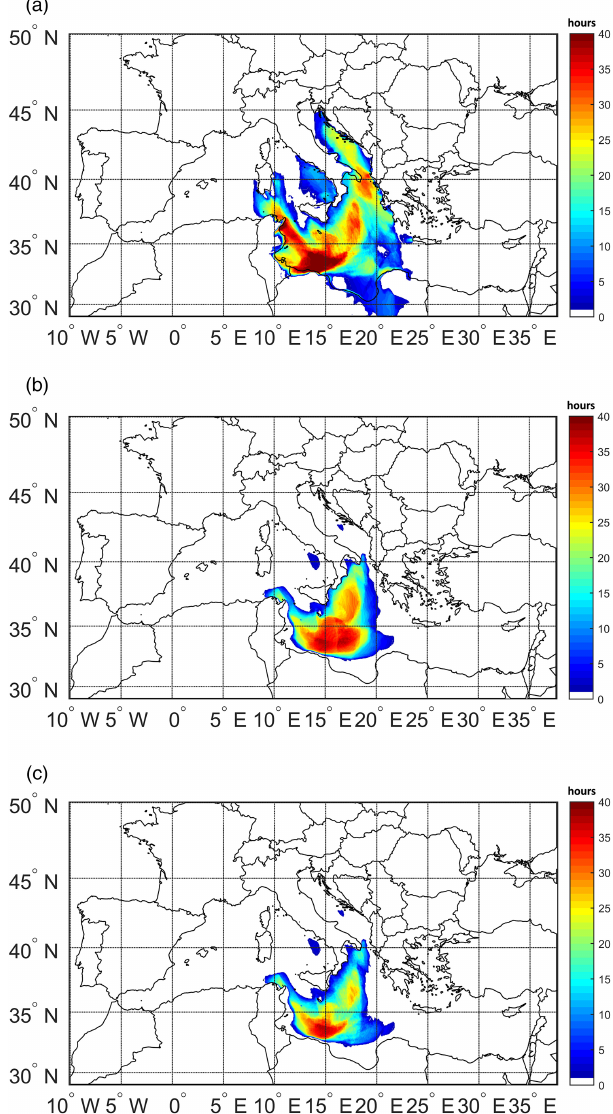
Figure 10. (a) Duration in hours per grid point where 925hPa wind speed exceeds the threshold of 17.5ms − 1 during the lifetime of medicane Qendresa (2014). Panel (b) like in (a) but for significant wave height exceeding 4m. Panel (c) like in (a) but for the com- bined threshold values of both wind speeds and wave height. Fields are derived from coupled wave–atmosphere model. Reprinted from Patlakas et al. (2020) with